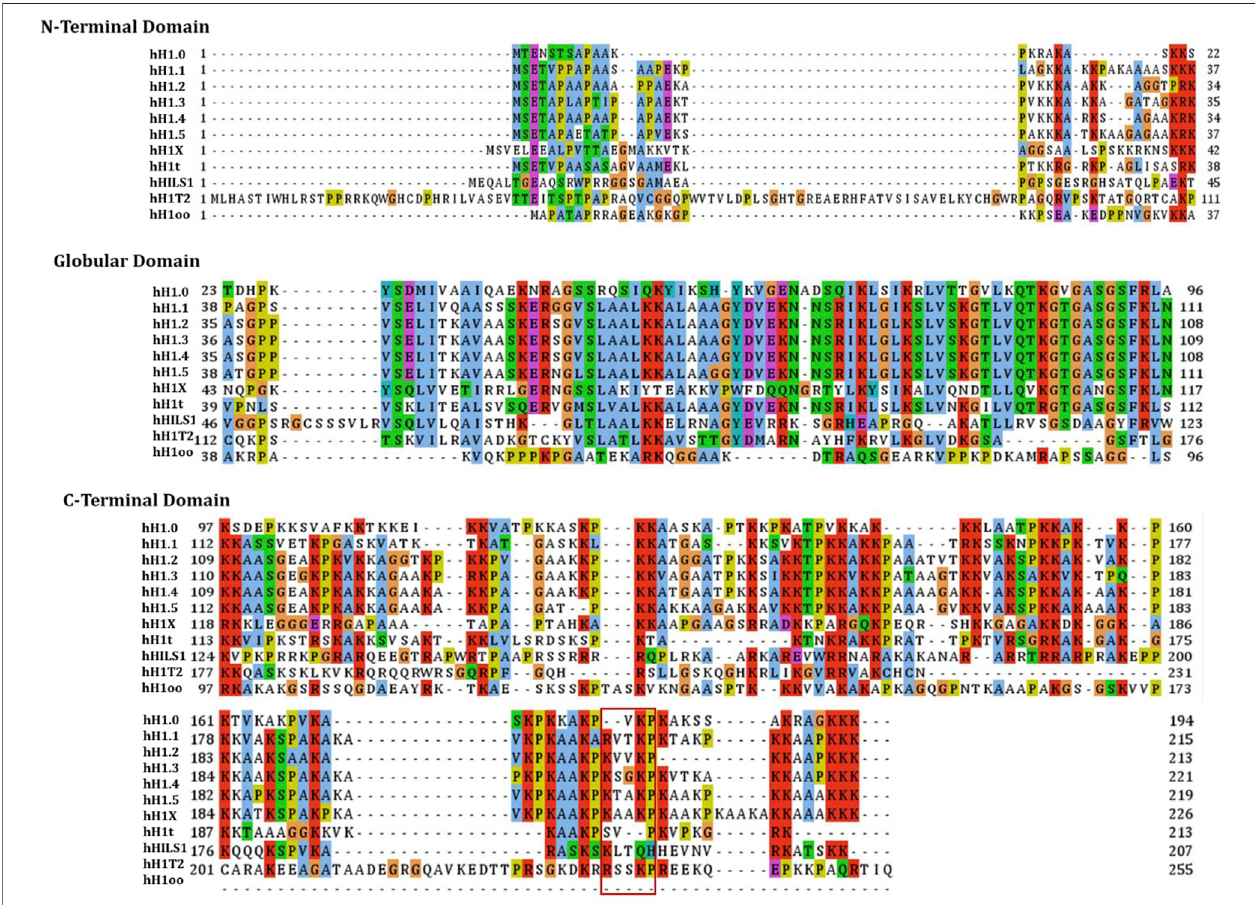
FIGURE 1 | The sequence alignment of the human linker histones H1 family. Sequence alignment of 11 variants of human histone H1 were carried out by using Jalview, and the individual histone H1 variants sequences were downloaded from NCBI. The globular domain is highest conservation and the C-terminal tail is lowest conservation, and the K/RVVKP motif has only a low conservation amongst H1.1-H1.5 and HILS1.